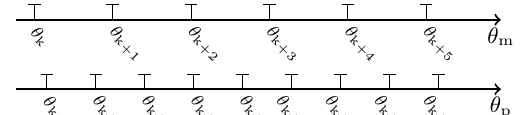
Figure 16: Input decision scheme for a digital hydraulic transmission with a high and a low speed digital displacement machine.